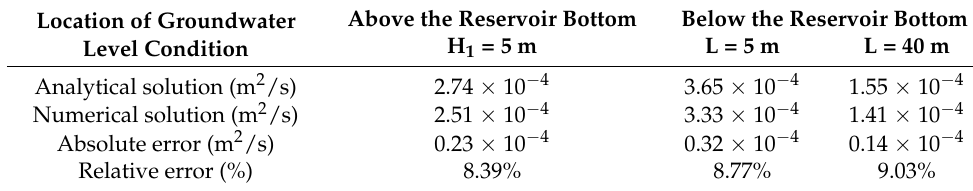
Figure 17. Streamline directions and piezometric lines of the reservoir bottom. ( a ) Groundwater level above the reservoir bottom. ( b ) Groundwater level below the reservoir bottom (L = 5 m). ( c ) Table 3. Leakage from the bottom.